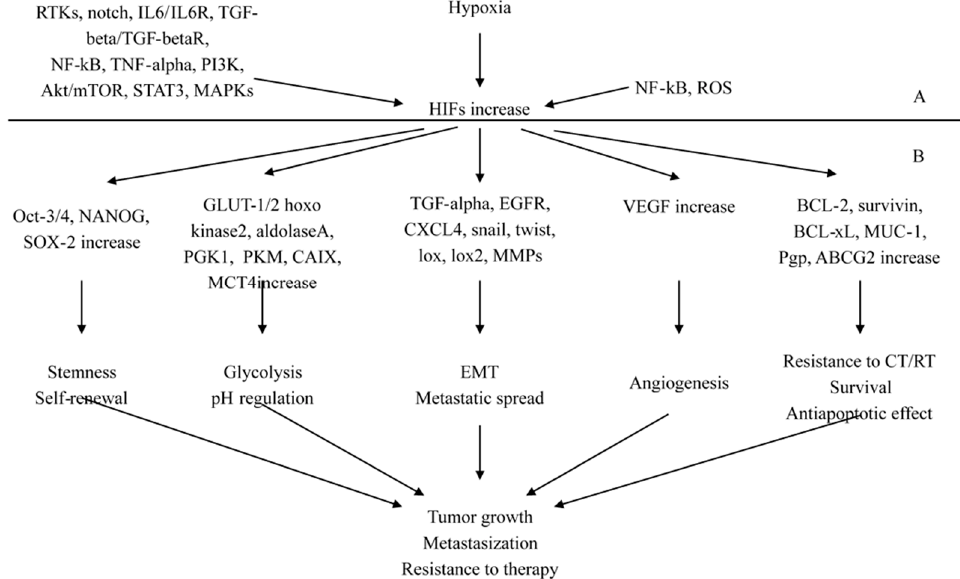
Figure 4. Hypoxia inducible factors (HIFs): ( A ) signaling mediated involvement in the regulation and activation of HIFs; and ( B ) signaling factors and programs promoted by HIFs. BCRP/ABCG2: breast cancer resistance protein; CAIX: carbonic anhydrase; EGFR: epidermal growth factor receptor; GLUT: